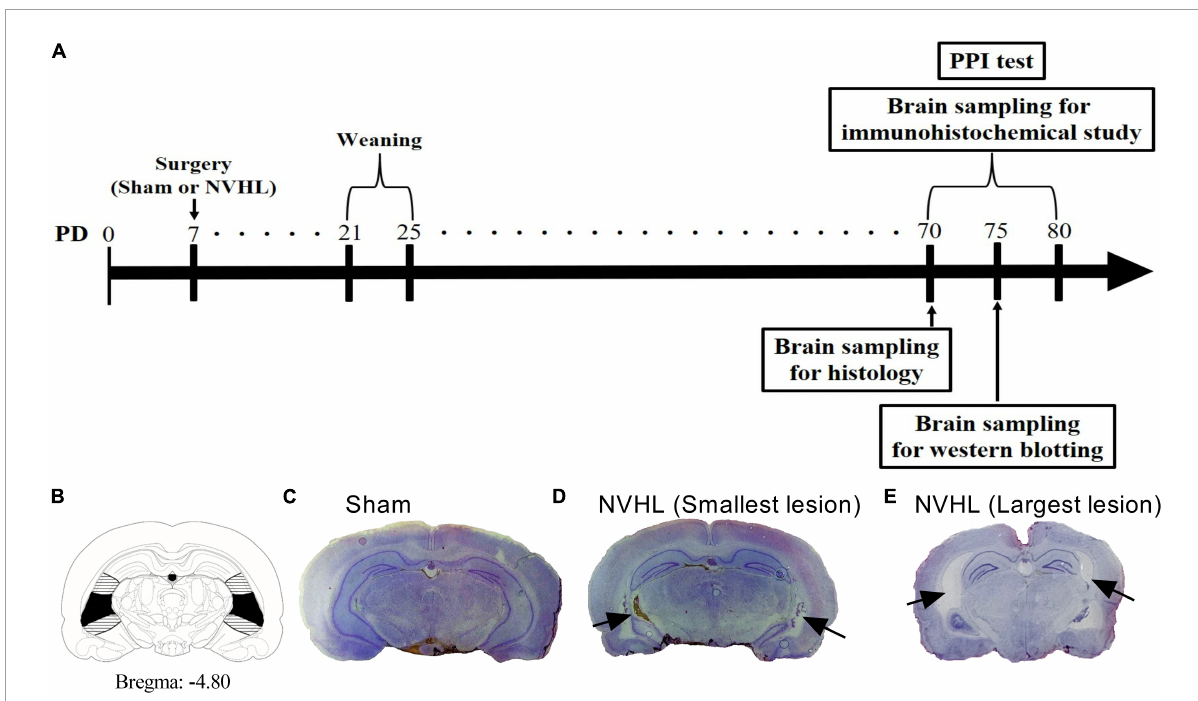
FIGURE1 Experimental time course for protocol (A) . (B) Diagram showing the dorsal to ventral hippocampus. Horizontal bars and blackened areas indicate the largest and smallest lesions, respectively. (C) Sham rat. (D) NVHL rat (smallest lesion). (E) NVHL rat (largest lesion). A typical cresyl violet stained coronal sections at the level of ventral hippocampus of a PD 70 rat indicating ibotenic acid induced neuron loss (arrow) in the ventral hippocampus (D,E)